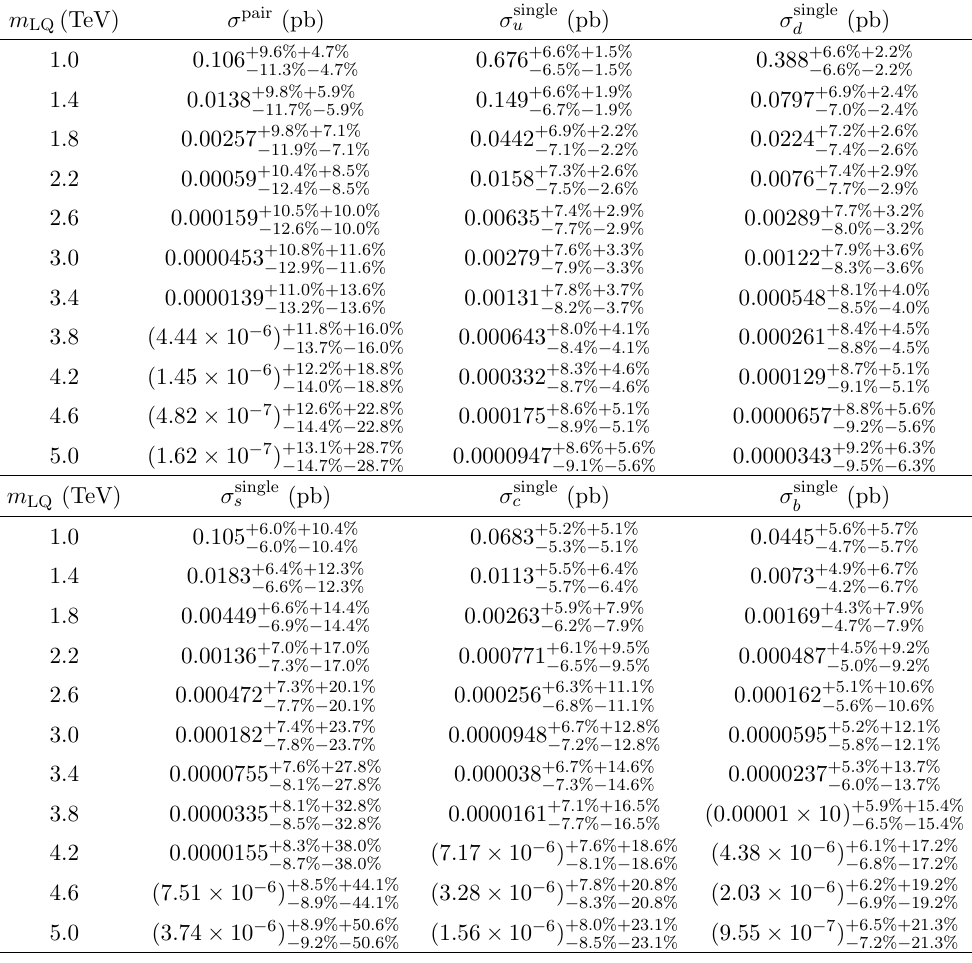
Table 3 . Total inclusive cross sections in pb for the PDF4LHC15 PDF sets [29] as a function of the LQ mass at 27 TeV center-of-mass energy for the proton-proton collisions. (cid:27) pair corresponds to the LQ pair production. (cid:27) single describe single LQ productions through corresponding quark (cid:13)avour u;d;s;c;b when the associated Yukawa coupling strength is set to one. The cross section dependancy on the change in the renormalisation ( (cid:22) R ) and factorisation ( (cid:22) F ) scales is taken into account through the following scale variations: (cid:22) R = (cid:22) F = m LQ = 2 ; m LQ ; 2 m LQ . First (second) uncertainty is due to the renormalisation (cid:22) R and factorisation (cid:22) F scale (PDF) variations and is given in per cent units.